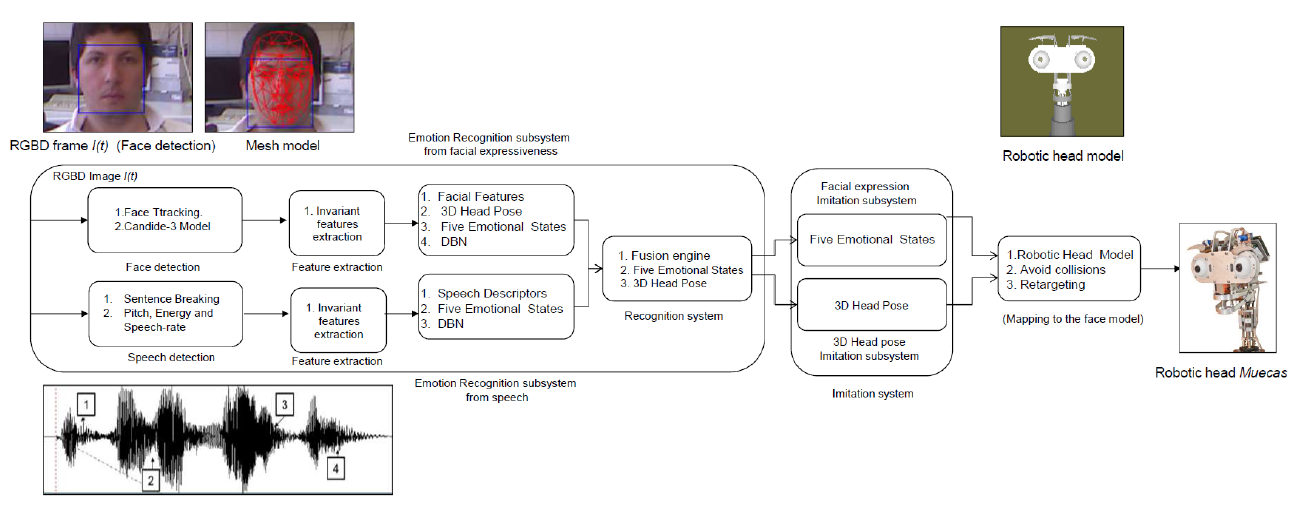
Figure 9. Overview of the imitation system proposed in this